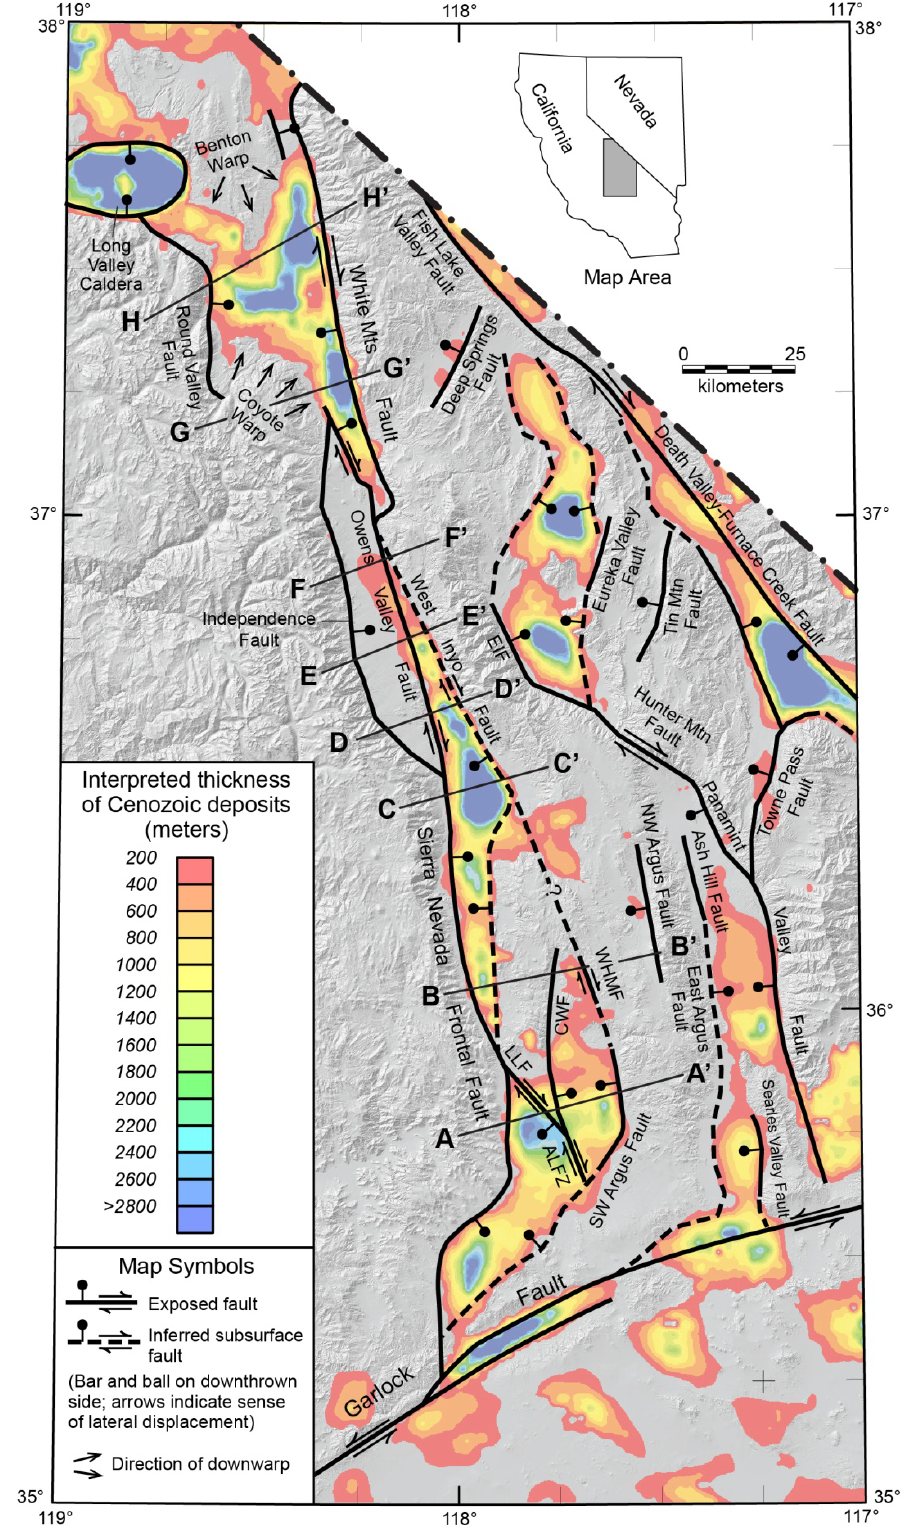
Figure 5. Map showing interpreted thickness of Cenozoic deposits and major faults outlining the deep basins, based on inversion of gravity data [56]. Connection between West Inyo and Southwest Argus faults from Pluhar et al. [58]. ALFZ = Airport Lake Fault Zone; CWF = Coso Wash Fault; EIF = East Inyo Fault; LLF = Little Lake Fault. A-A' to H-H' indicate lines of cross sections and gravity profiles shown in Figure